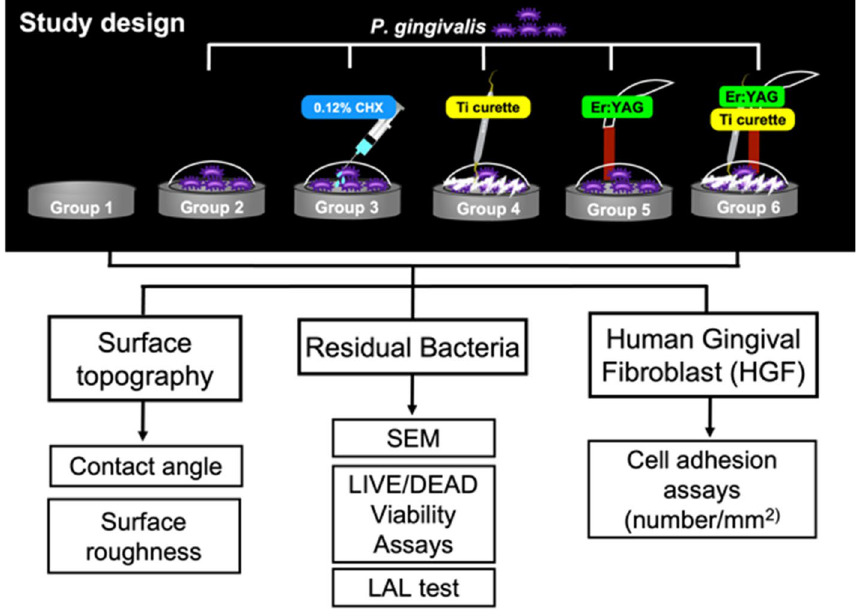
Figure 7. The study design consisted of 3 parts, including P. gingivalis bacterial assessment, an HGF adhesion test, and surface topography analysis. Group 1: negative control; Group 2–Group 6: P. gingivalis adhesion on titanium discs; Group 2: positive control without treatment; Group 3: treatment with 0.12% CHX; Group 4: mechanical debridement with Ti curettage; Group 5: treatment with Er:YAG laser irradiation; Group 6: combined debridement with Ti curettage and Er-YAG laser